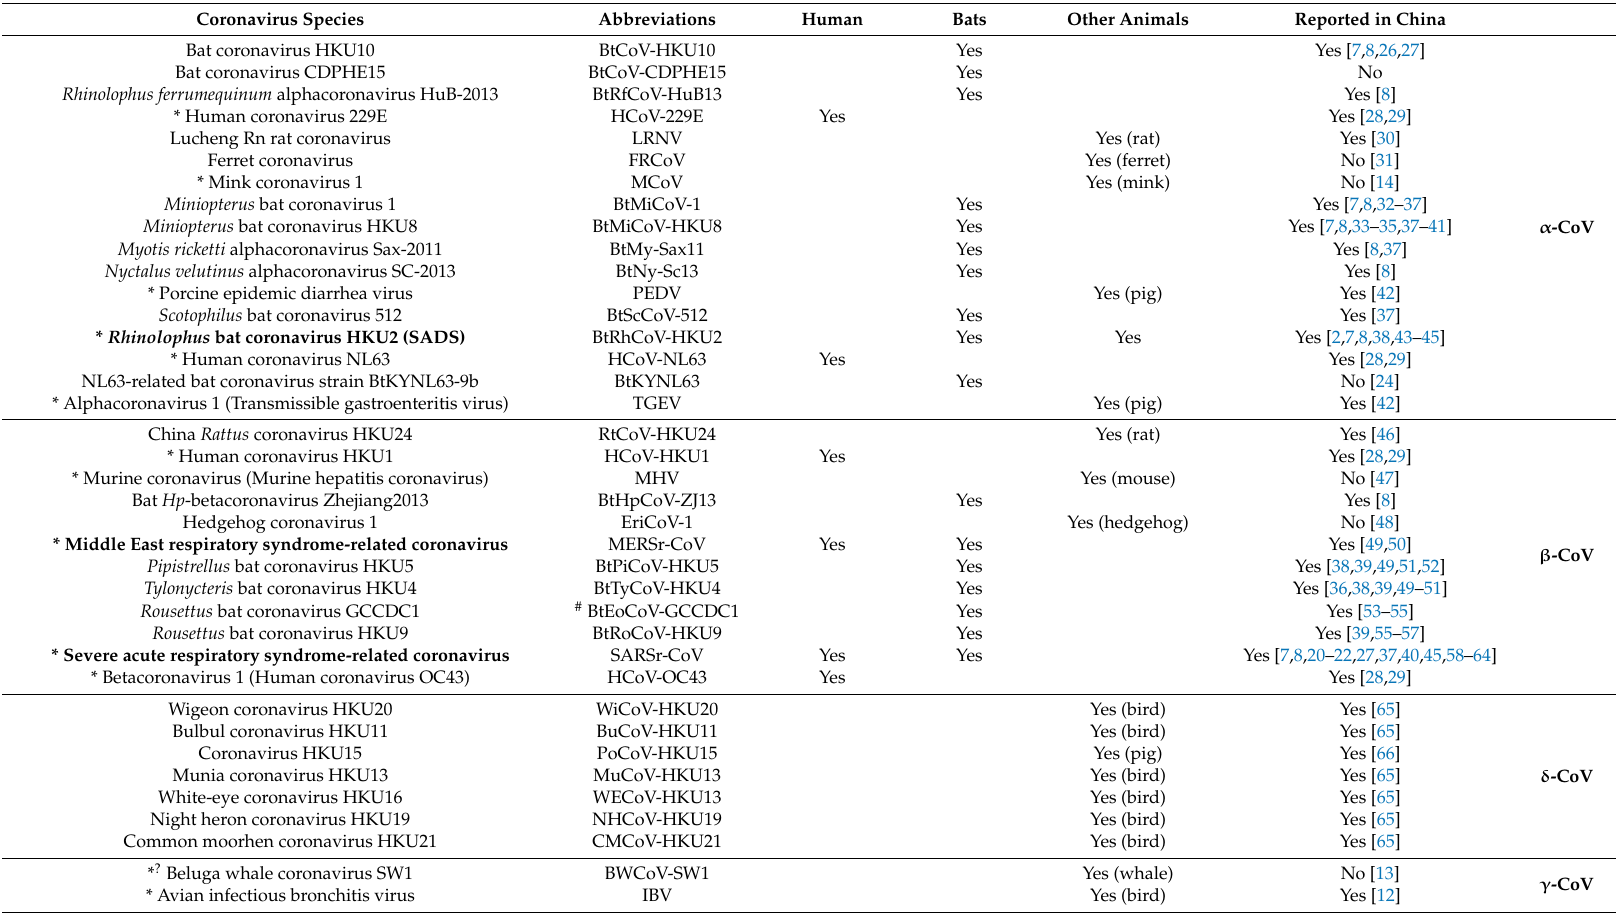
Table 1. International Committee of Taxonomy of Viruses (ICTV) classification of coronaviruses species, reservoir hosts, and presence reported in